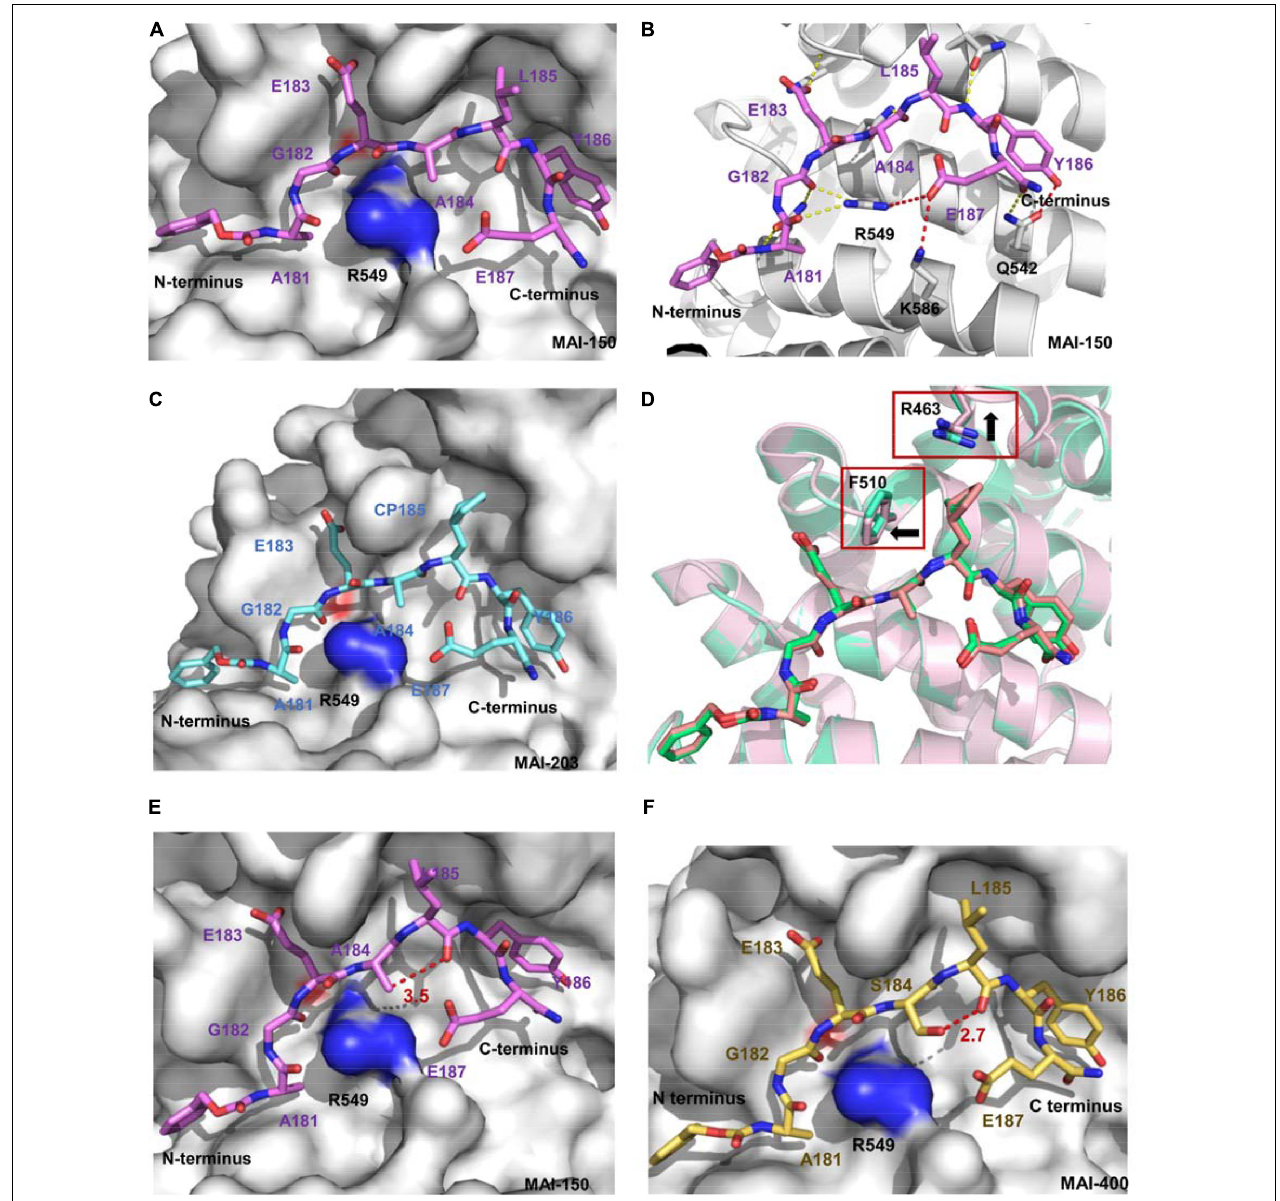
FIGURE 5 | (A) Crystal structure of APC and MAI-150 (5IZ6). APC is shown as a surface representation (gray), and MAI-150 is shown as a stick representation (pink). (B) The interactions of APC and MAI-150 (APC, cartoon, gray; MAI-150, stick, pink). Yellow dashed lines represent hydrogen bonds. Red dashed lines represent new hydrogen bonds. (C) Crystal structure of APC and MAI-203 (5B6G). APC is shown as a surface representation (gray), and MAI-150 is shown as a stick representation (blue). (D) A structural comparison of APC/MAI-150 (APC, cartoon, pink; MAI-150, stick, pink) and APC/MAI-203 (APC, cartoon, cyan; MAI-203, stick, cyan). (E) Crystal structure of APC and MAI-150. APC is shown as a surface representation (gray), and MAI-150 is shown as a stick representation (pink). (F) Crystal structure of APC and MAI-400 (5Z8H). APC is shown as a surface representation (gray), and MAI-400 is shown as a stick representation (yellow). Red dashed lines represent hydrogen